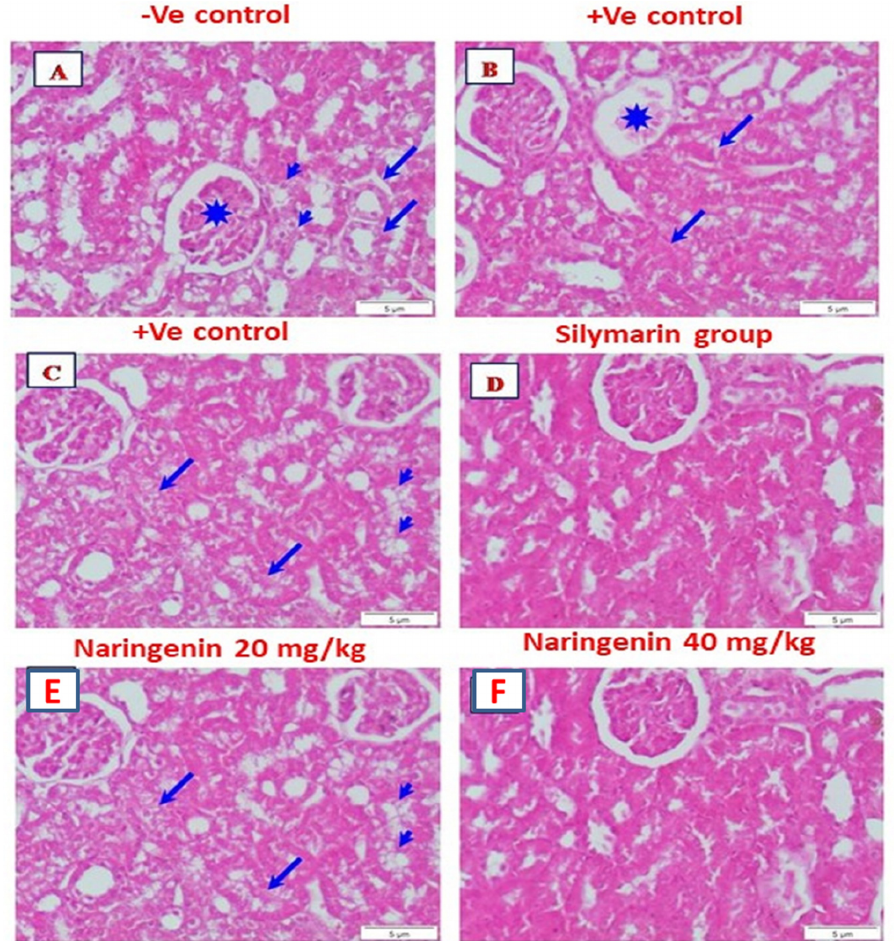
Figure 2. Photomicrograph of the kidney tissues using hematoxylin and eosin (H&E) staining: ( A ) Negative control rat showing normal structures of the renal corpuscle (asterisk) and renal tubules, as well as distal (arrows) and proximal (arrowheads) convoluted tubules. ( B ) Rat given CCl 4 (posi- tive control) showing partially degenerated glomerulus (asterisk). Focal interstitial hemorrhage is seen (arrows). ( C ) Rat given CCl 4 showing necrosis of the renal tubules (arrows). Some renal tubules show complete degeneration (arrowheads). ( D ) Rat given CCl 4 and treated with silymarin showing the renal corpuscle and renal tubules, which appear as nearly normal. ( E ) Rat given CCl 4 and treated with naringenin (20 mg/kg) showing the renal corpuscle and renal tubules, which appear as nearly normal. Note the degenerative renal tubules (arrows). ( F ) Rat given CCl 4 and treated with naringenin (40 mg/kg) showing the renal corpuscle and renal tubules, which appear as more or less normal (H&E; scale bar: 5 μ m).